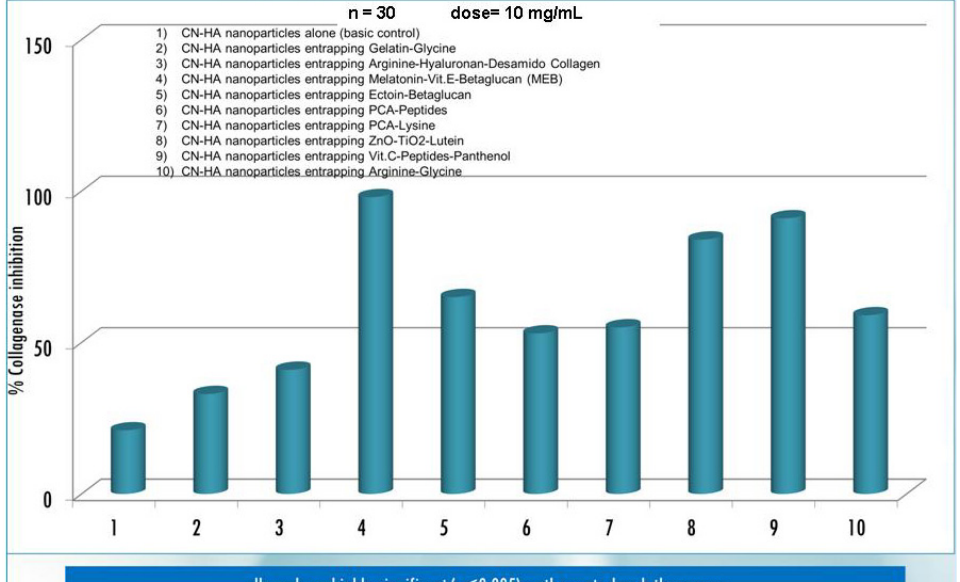
Figure 14. Inhibitory activity vs. collagen degradation of chitin nanofibrils-hyaluronan nanoparticles entrapping active ingredients in fibroblast culture incubated collagenase enzyme. All p values highly significant ( p < 0.005) as the control and